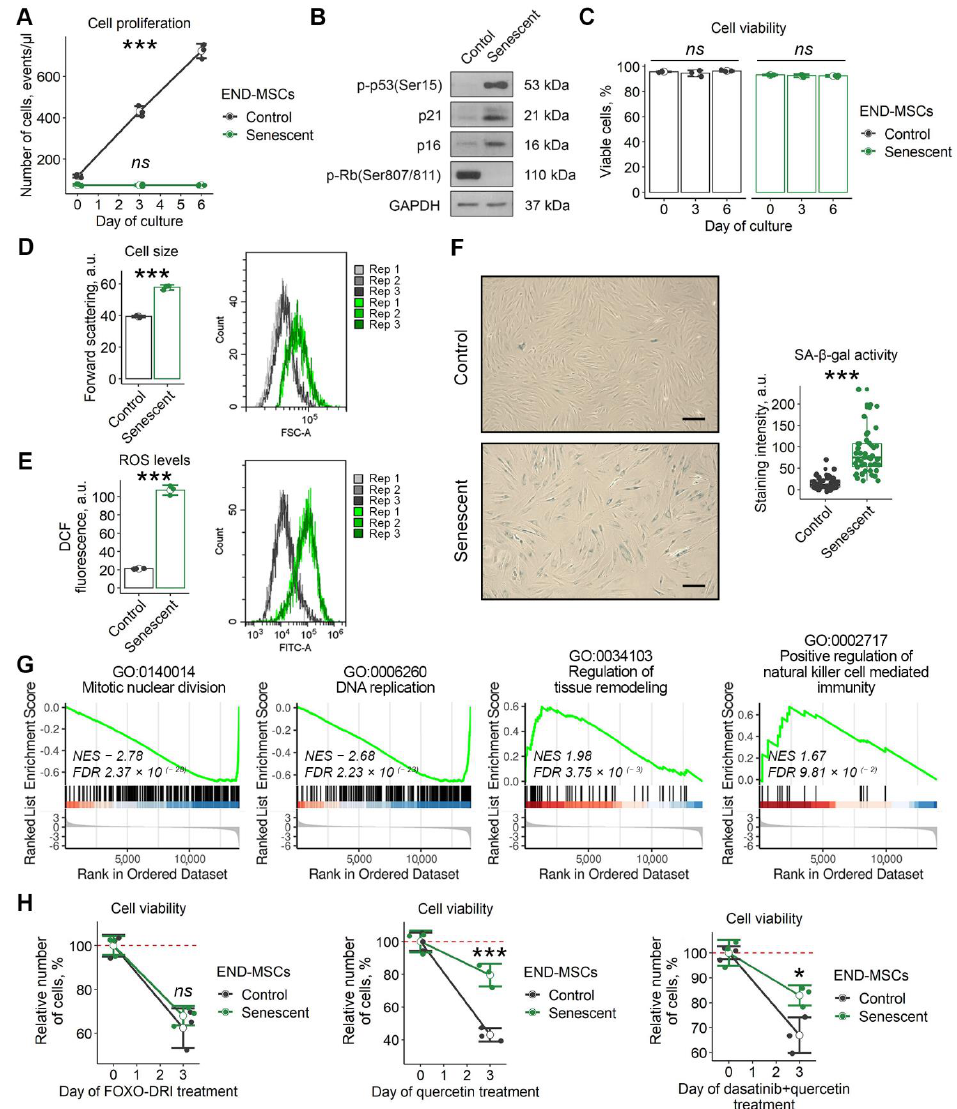
Figure 1. Senescent END-MSCs exhibit resistance to established senolytics treatment. The senescence state of END-MSCs was induced by oxidative stress (1 h, 200 µ M H 2 O 2 ) and verified by ( A ) proliferation loss and ( B ) activation of p53/p21/Rb and p16/Rb pathways mediating cell cycle arrest, ( C ) retained viability, ( D ) cell hypertrophy, ( E ) elevated intracellular ROS levels, ( F ) acquisition of senescence-associated activity β -galactosidase (SA- β -gal), ( G ) suppression of mitotic machinery, DNA replication and activation of tissue remodeling and pro-inflammatory gene expression profile compared to control cells (Supplementary Table S1 and S2). ( H ) Senescent END-MSCs display equivalent (25 µ M FOXO4-DRI) or higher (100 µ M quercetin, 500 nM dasatinib + 100 µ M quercetin) resistance to death, data presented as relative cell viability (%) of control and senescent END-MSCs 3 days after treatment with each substance. Values presented are mean ± s.d. For multiple group comparisons at ( A , C ) one-way ANOVA was applied, n = 3, ns—not significant, *** p < 0.005. For pair comparisons at ( B , C,E ) Welch’s t-test was used, n = 3 for ( D , E ), n = 50 for ( F ), *** p < 0.005. For comparison of viability of control and senescent cell with treatment at ( H ) two-way ANOVA with Tukey’s HSD was applied, n = 3, ns—not significant, * p < 0.05, *** p < 0.005. For functional annotation of senescent vs. control END-MSCs transcriptomic profiles, comparison GSEA (Gene set enrichment analysis) in GO:BP terms was used, n = 4 for each group (Supplementary Tables S1 and S2). Scale bars for images are 100 µ m. Full-length blots are presented in Supplementary Figure S1A; GAPDH was used as loading